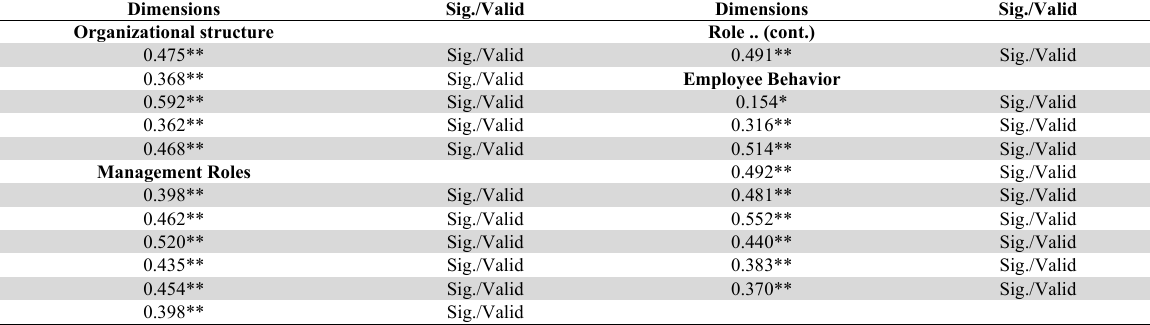
Validity between Items with Variable Dimension Total